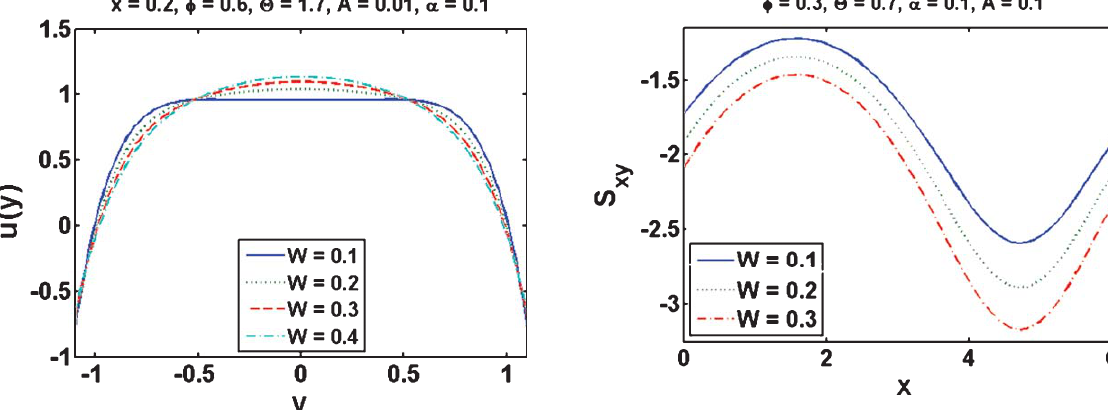
Fig. 7. Variation in shear stress ( S xy ) against y for different values of fluid parameter ( W ).